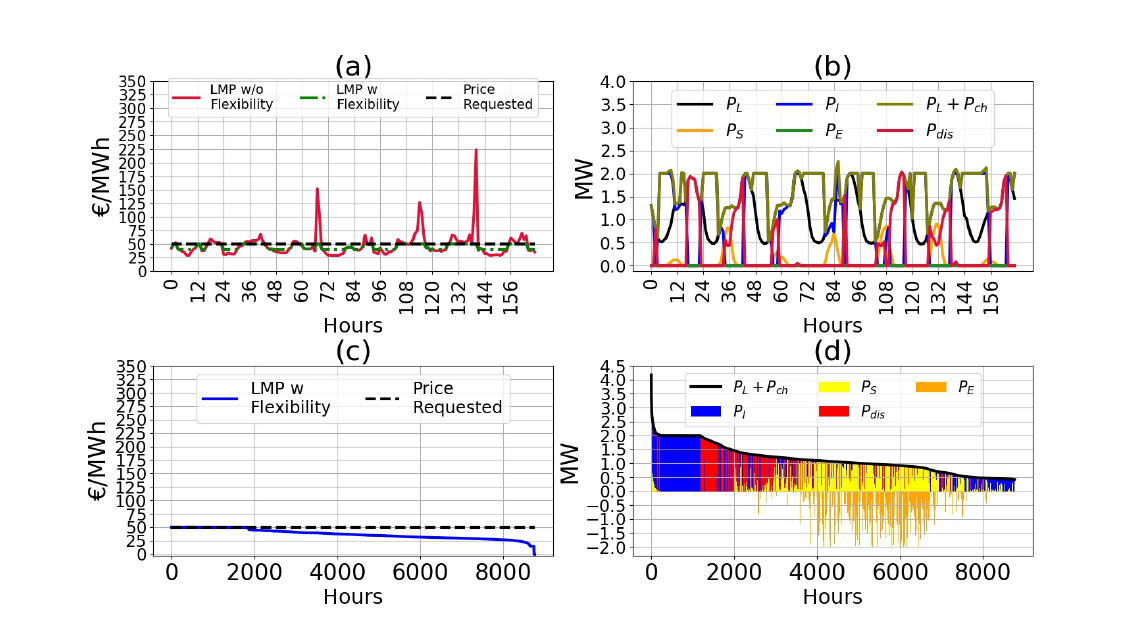
Figure 5. Demand, generation, and prices in the case of providing flexibility with an energy storage system. ( a ) Local electricity prices for a typical week. ( b ) Demand and generation for the same week. ( c ) Price duration curve. ( d ) Load duration curve, the generation, and grid imports and exports. A price limit of e 50/MWh was used in this case and is indicated in the price